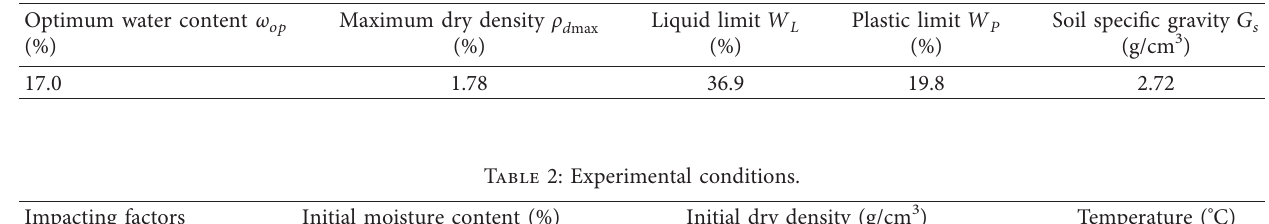
Figure 2: Compaction curve of Table 1: Basic physical parameters for the soil specimens.